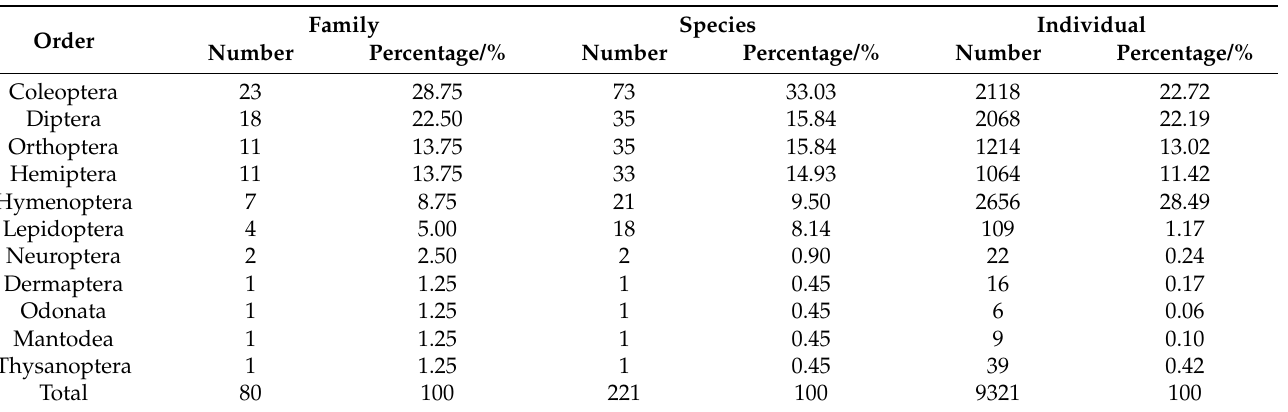
Table 2. Composition of insect communities in typical vegetation community ecosystems along altitudinal gradient of the Guandi Mountain.